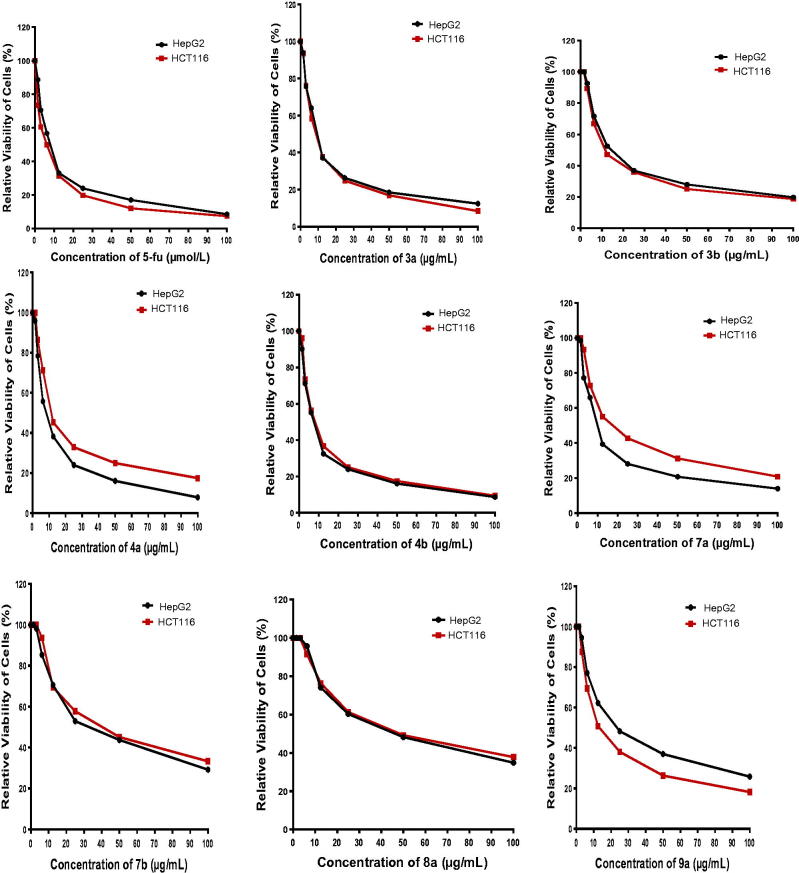
Relative viability of cells (%) against concentration of the newly synthesized compounds.